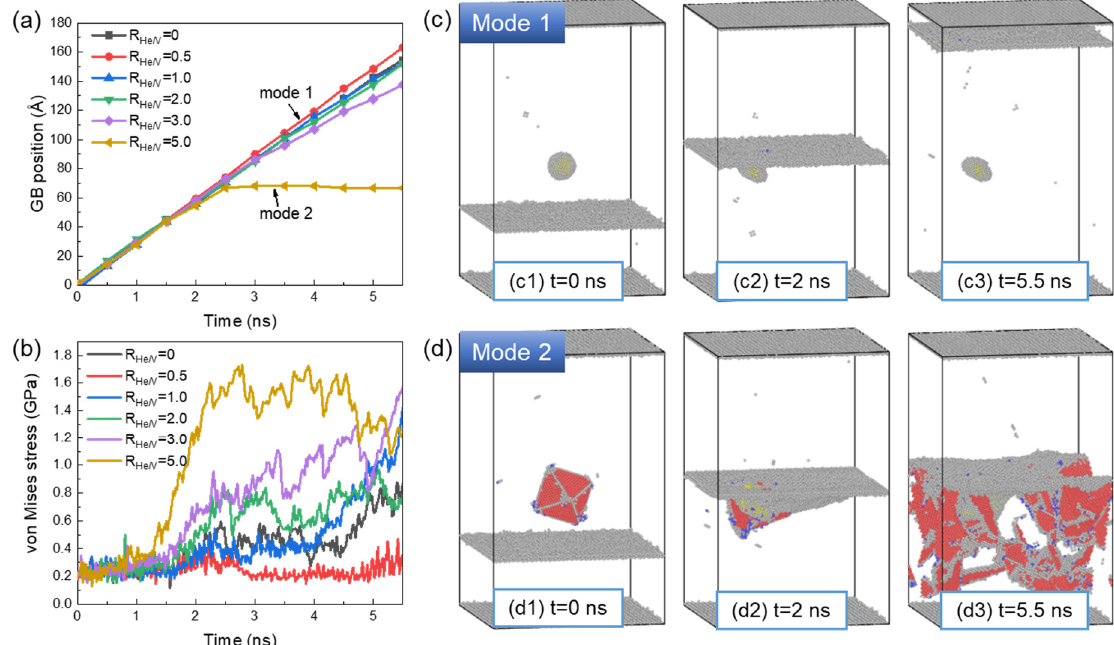
Figure 2. Snapshots of the different interaction modes between GB and He bubble at T 0 = 300 K and D 0 = 2 nm. ( a ) GB position; ( b ) von Mises stress; ( c ) Mode 1, R He/V = 0.5; ( d ) Mode 2, R He/V = 5.0. He atoms are colored in yellow and other atoms are colored based on a-CNA (adaptive common neighbor analysis), where red atoms represent HCP structure, and white atoms represent disordered at- oms.